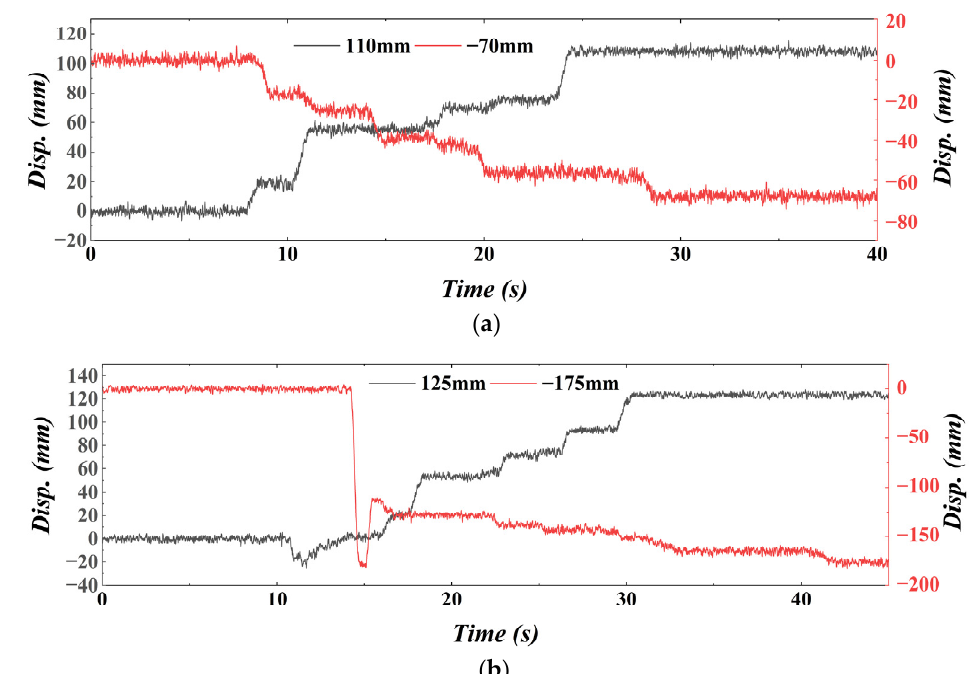
Figure 28. Height time history curves at different wind speeds: ( a ) 24 m/s and ( b ) 30 m/s.